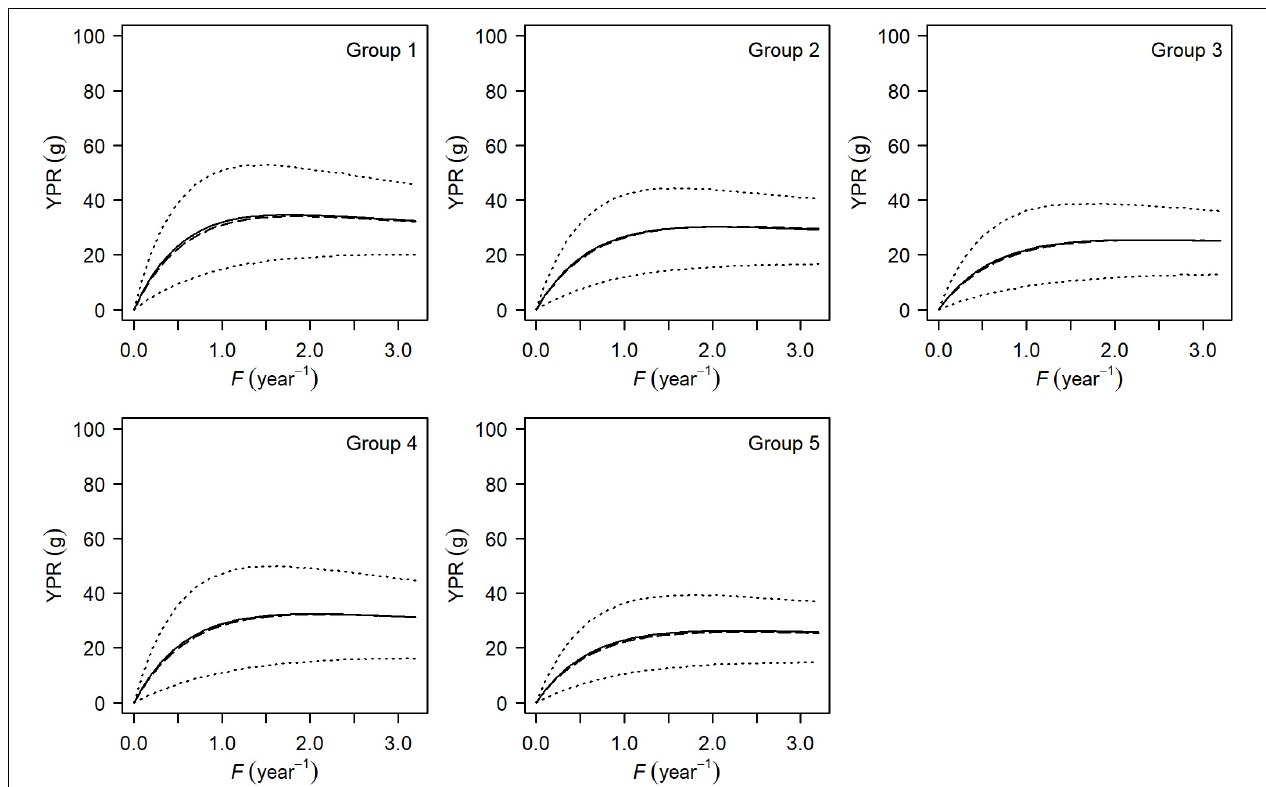
FIGURE 5 | Mean (solid line), median (long-dashed line), and the 95% HDI (dotted line) of yield-per-recruit curves for each group of small yellow croakers when t max = 3